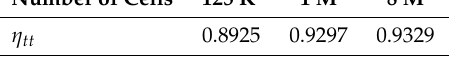
Table 1. Results of grid refinement study on the TK9-TW3 geometry—MRF method.